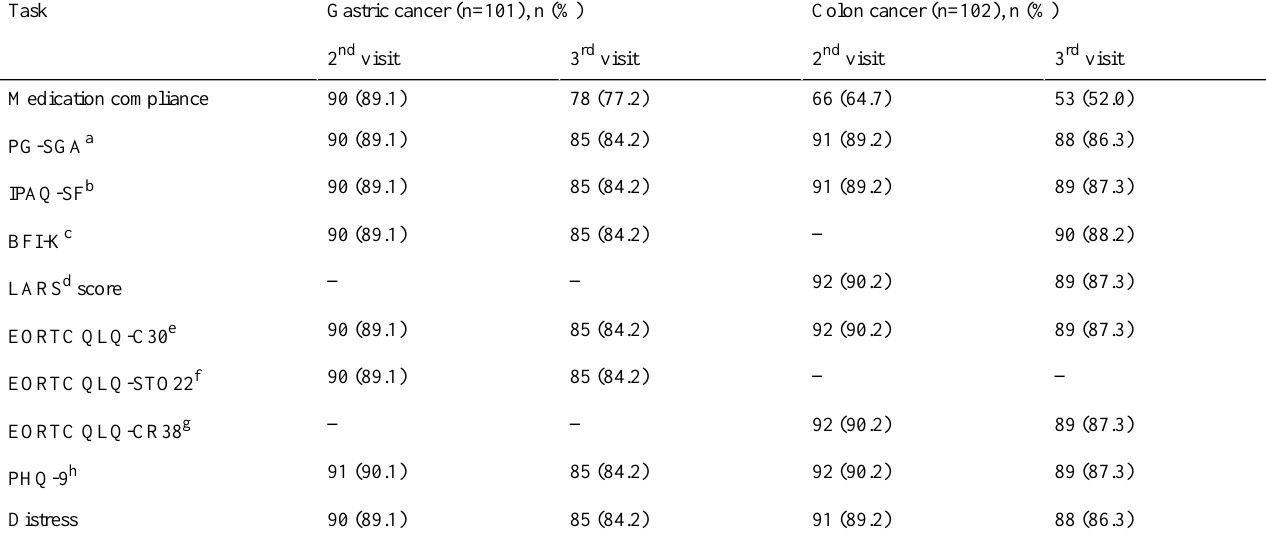
Table 4. Response rate for the offline surveys.